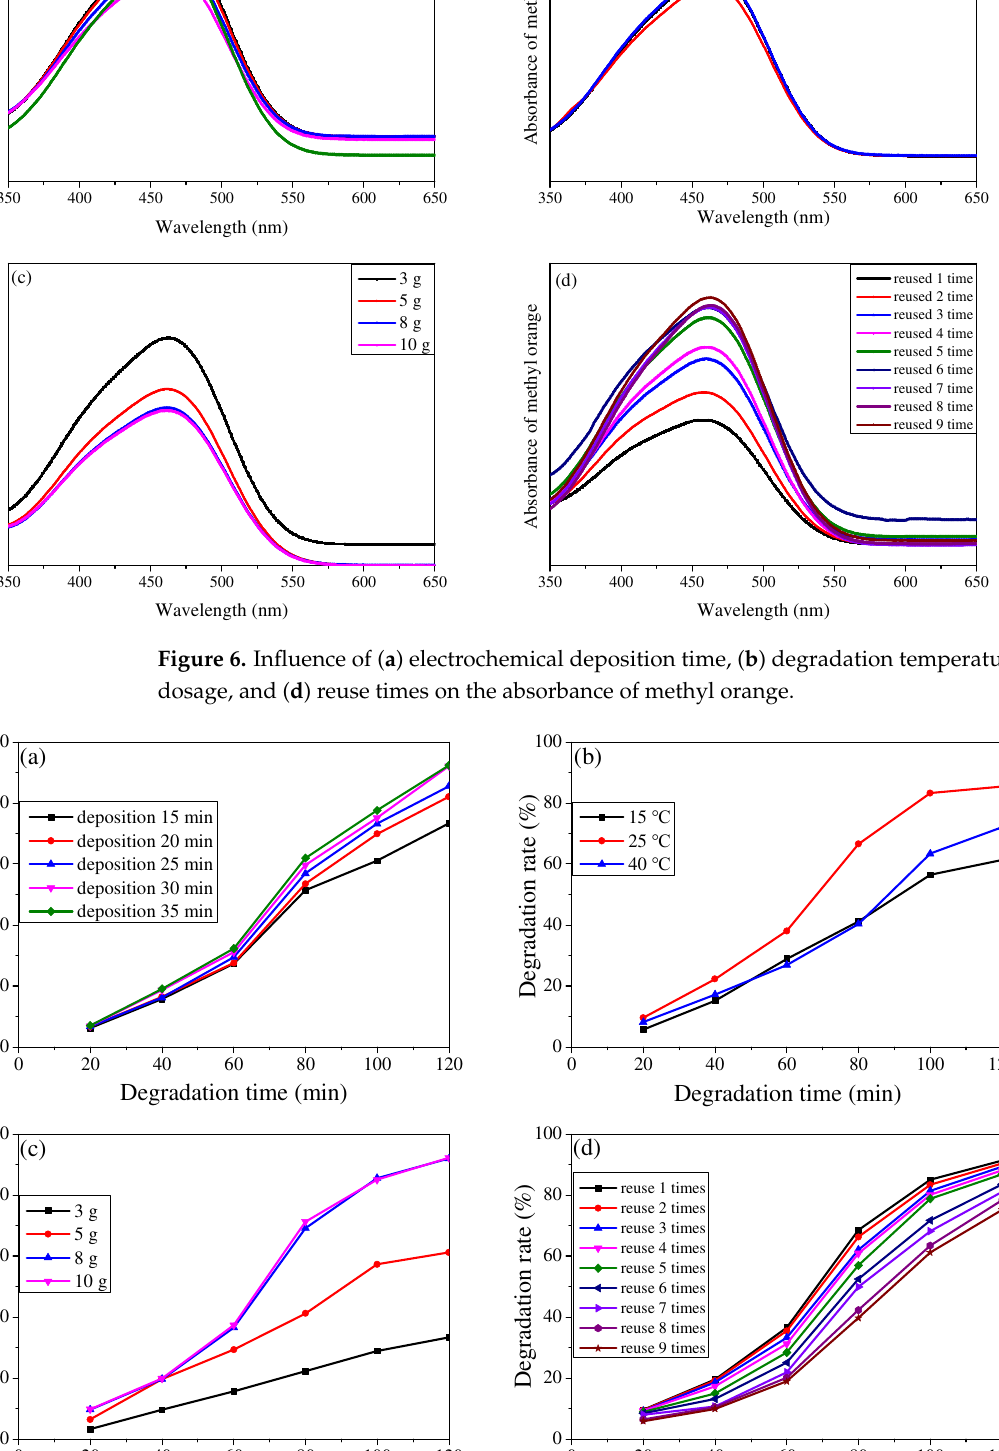
Figure 7. Influence of ( a ) electrochemical deposition time, ( b ) degradation temperature, ( c ) catalyst dosage, and ( d ) reuse times on the degradation rate of methyl orange.